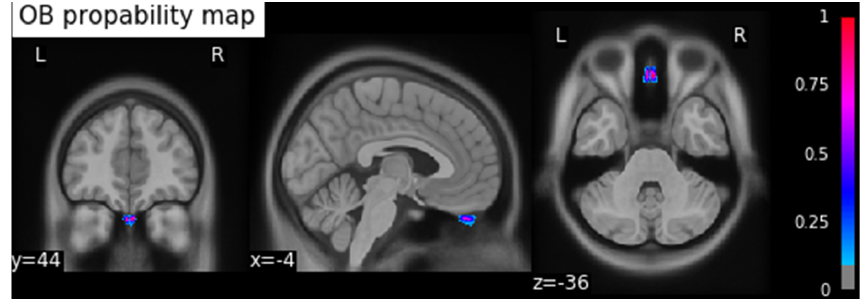
Figure 1. OB probability map: background image MNI ICBM 2009c Nonlinear Asymmetric template, threshold 0.5. The coordinates of the COG are xyz: − 4/44/ − 36. (x: sagittal, y: frontal, z: axial orientations). The colormap indicates the probability from 0 to 1.